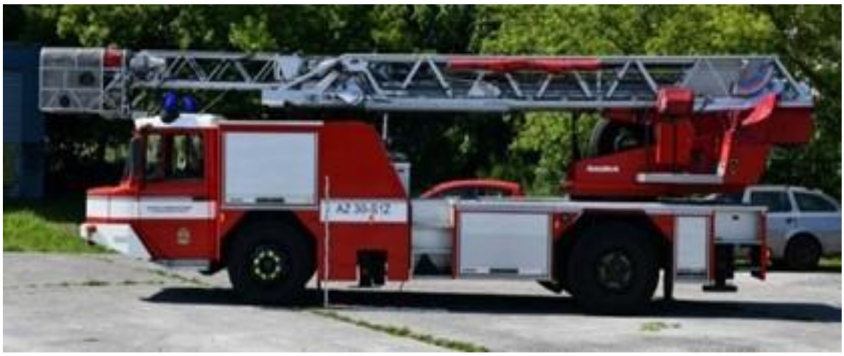
Figure 5. Photo of a fire engine ladder truck